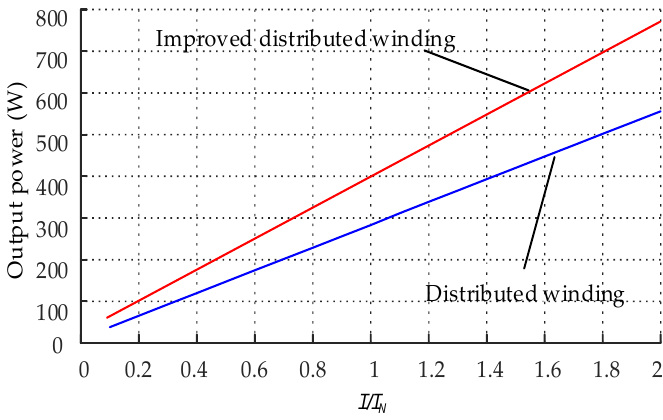
Figure 11. Curve of output power with current.